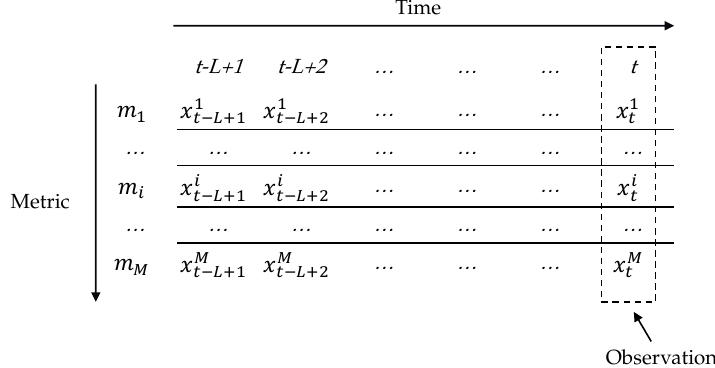
Figure 1. Window sample w t ∈ R M × L .